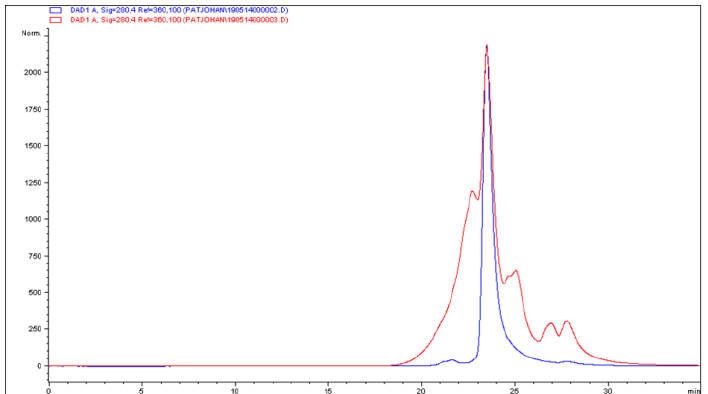
Figure 6. Size exclusion chromatogram of substrate 4 (blue). The reaction mixture after 21 hours with 5 equivalents TBHP and 1.5 mol% ([MoO 2 (SAP)] 2 ) in toluene at 80 °C (red). Mono-, dimers and small amounts of trimers are shown between 20 and 24 min. The smaller fragments correspond, in addition to 3,4-dimethoxybenzaldehyde, to molybdenum complexes (24 – 30 min).